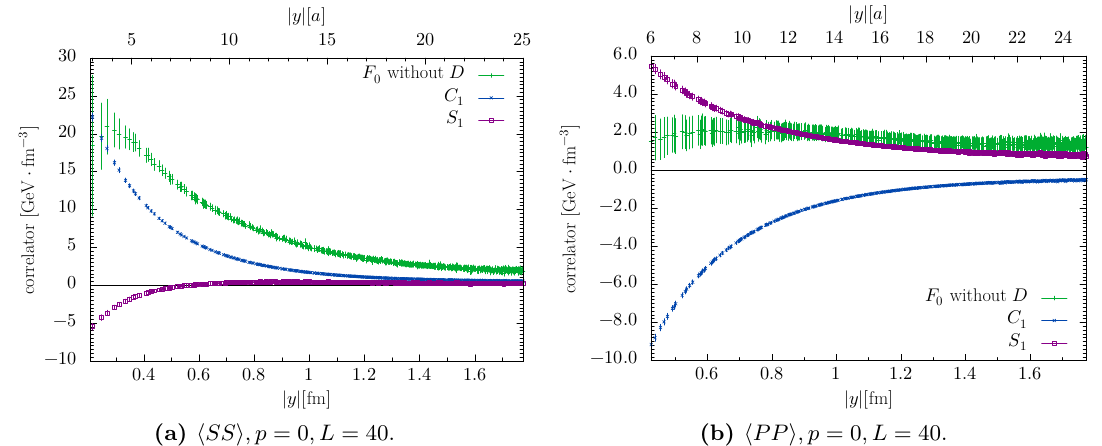
Figure 22. Comparison of F 0 with C 1 and S 1 for is omitted, as explained in the